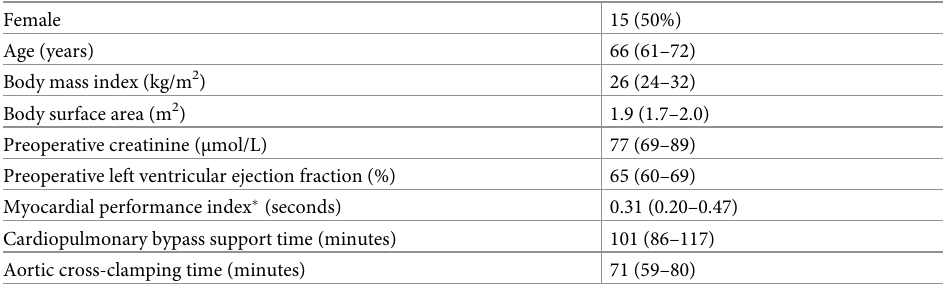
Table 1. Patient and procedure